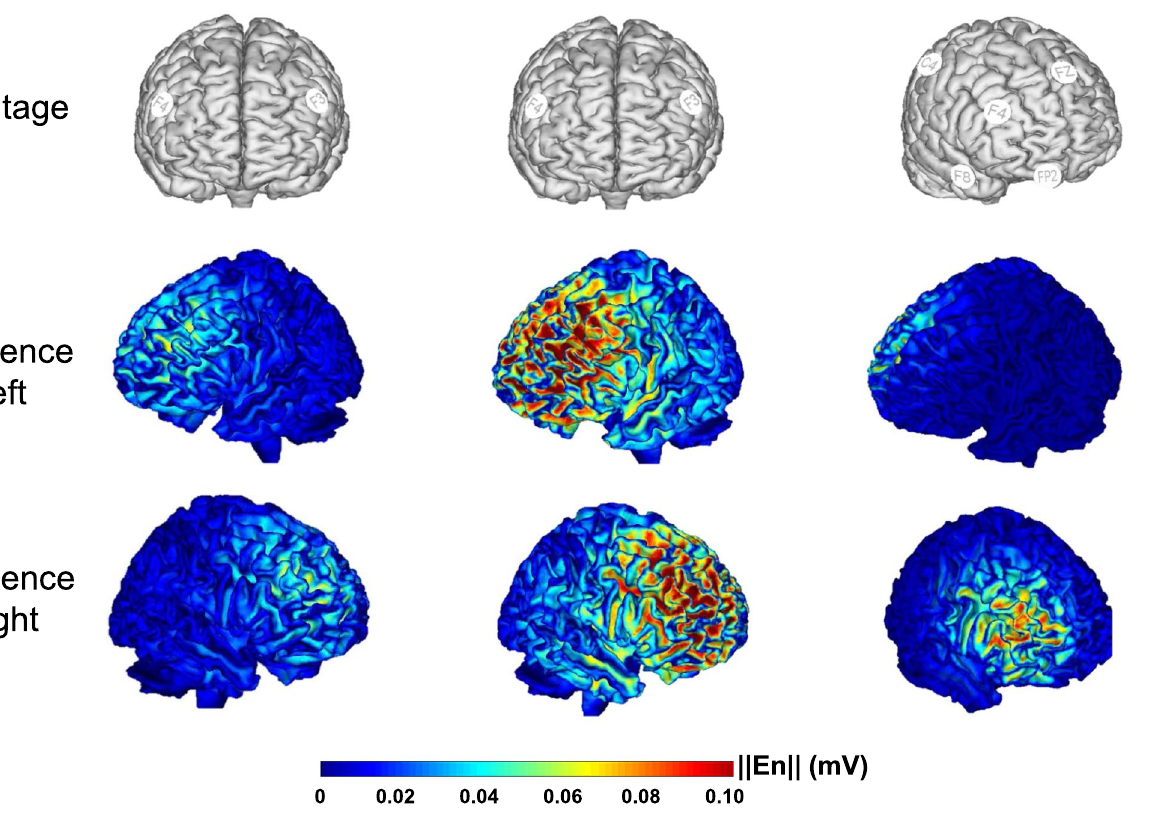
Figure 5. Stimulation montages and influence maps according to the montage type. Extracted from NIC2 software